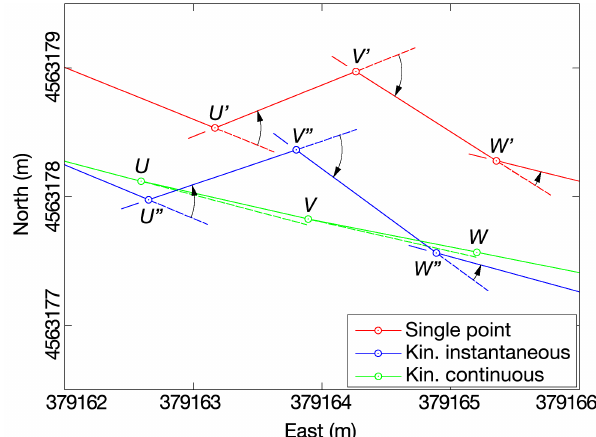
Figure 3. Scheme of the deflection angles referred to a portion of the